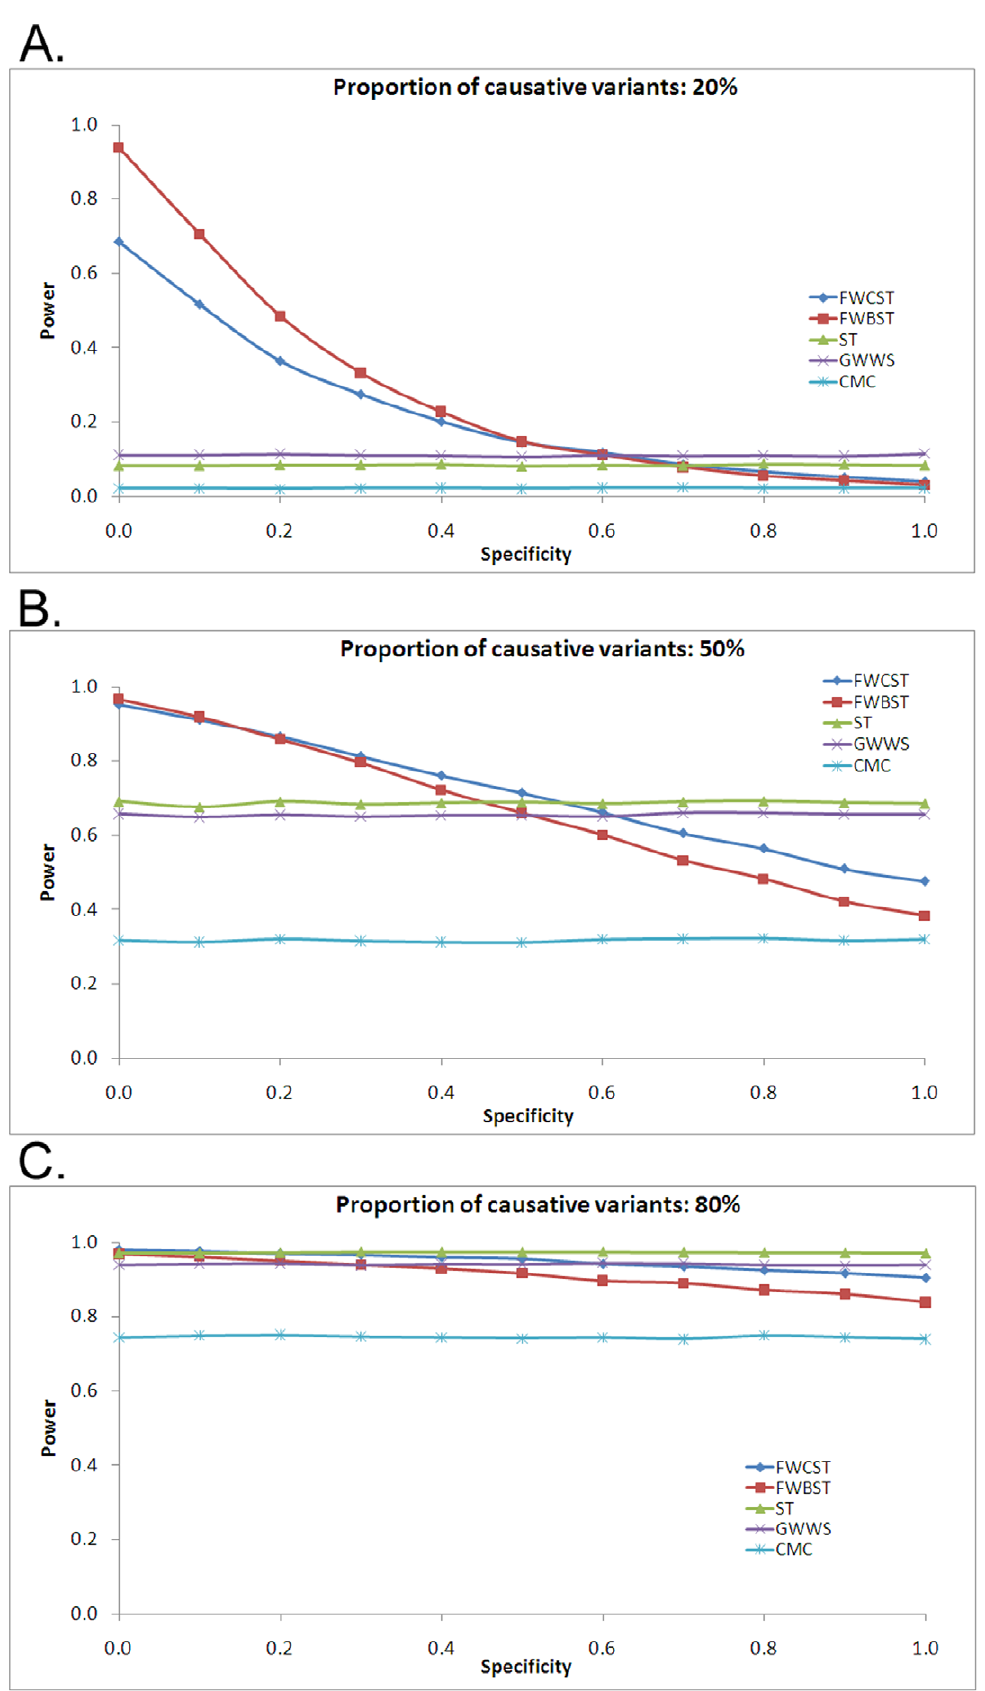
Figure 6. Power with specificity of predicting functional variants. The sensitivity for predicting functional variants is set to 0.8. See the legend for figure 4 for abbreviations and simulation detail. doi:10.1371/journal.pone.0013857.g006 PLoS ONE |